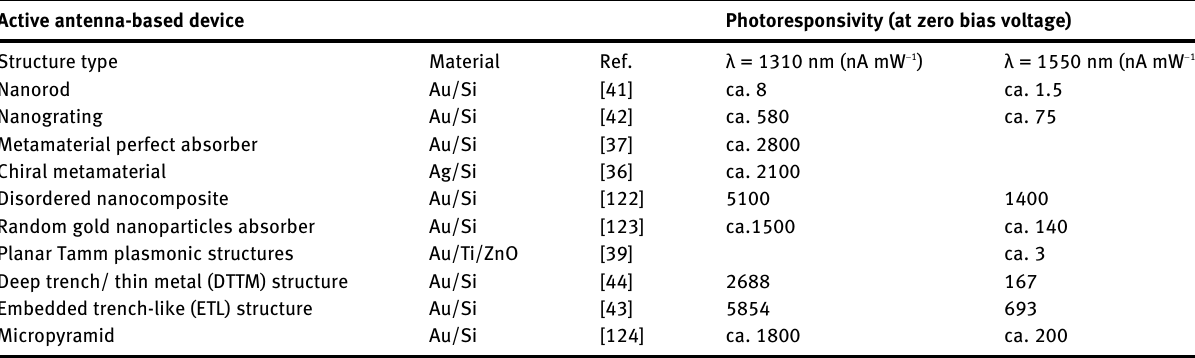
Table  : Properties (structure types, used materials, and photoresponsivity) of recently reported active antenna hot electron-based devices. Active antenna-based